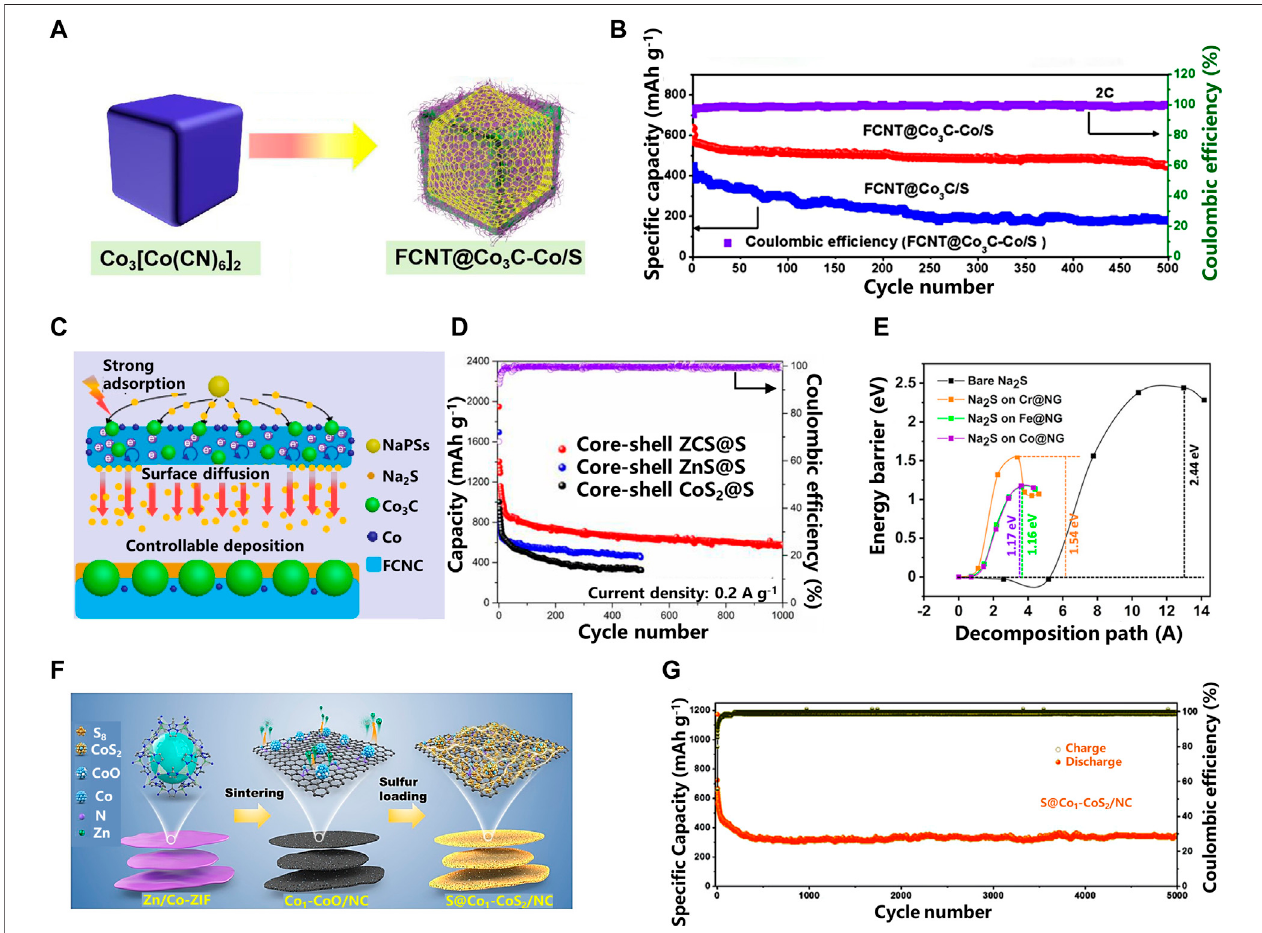
FIGURE4|(A) The SchematicofthePreparationofFCNT@Co (B) ThelongcyclingperformancesforFCNT@Co (C) 3 C-Co/S; 3 C/Sand FCNT@Co 3 C-Co/Sat 2C; The schematic diagram illustration of the Na 2 S deposition and growth process on FCNT@Co 3 C-Co/S; (D) Cycling performances at 0.2 A g − 1 of different cathode materials; (E) Decomposition barrier of bare Na 2 S and Na 2 S on TM@NG substrates; (F) Illustration of synthetic strategy to produce S@Co 1 − CoS 2 /NC; (G) Long-term cycling stability of